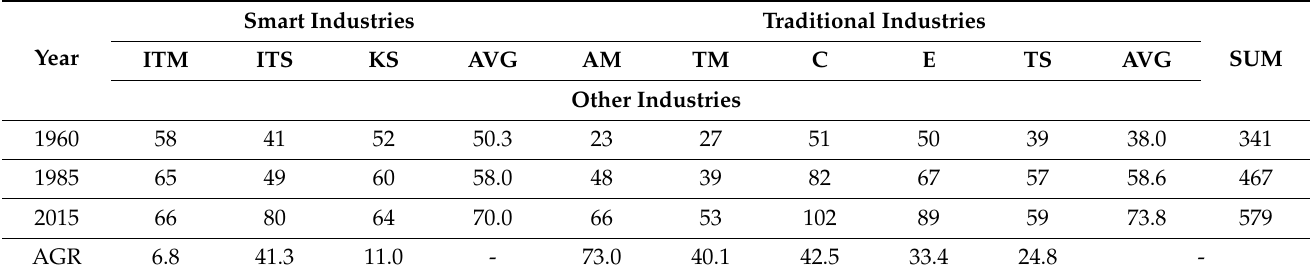
Table 3. Changes in smart production pathw (unit: no).